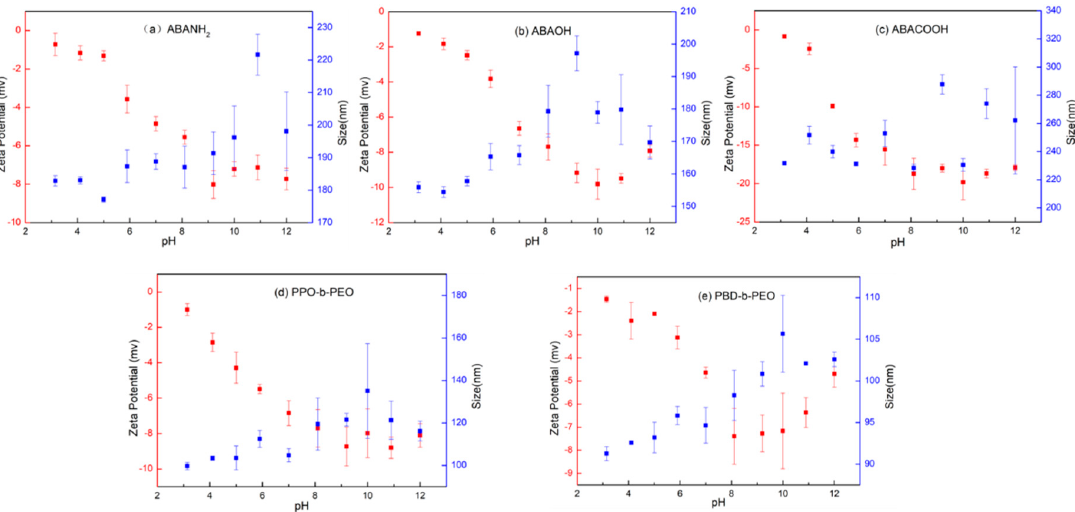
Figure 6. Zeta potential and size distribution of polymer vesicles self-assembled from ( a ) ABANH 2 , ( b ) ABAOH, ( c ) ABACOOH, ( d ) PPO- b -PEO, and ( e ) PBD- b -PEO under different pH values ranging from 3 to12.